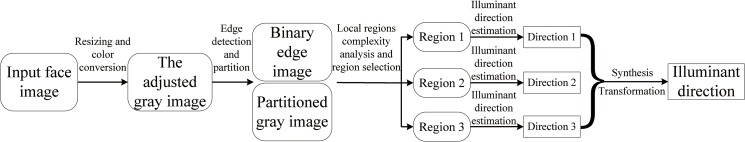
The main steps of the illuminant direction estimation method.It should be noted that three of sixteen local regions are selected to calculate the final illuminant direction.